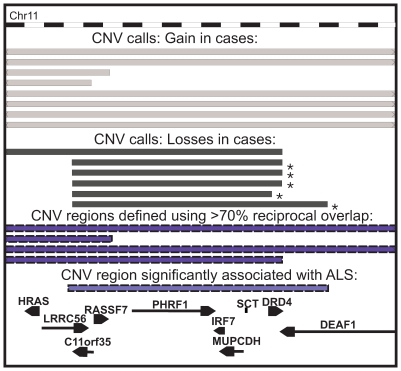
All CNV calls and CNV regions overlapping CNV region chr11: 539119-652407.Raw CNV calls are shown in dark grey. No control losses or gains were detected within the region shown but 8 gains in cases and 6 losses in cases were detected. Blue bars represent CNV regions defined by merging CNV calls that share a greater than 70% reciprocal overlap. The purple bar represents the CNV region found to show significant association in this study: the CNV calls that were merged into this CNV region are indicated with an asterisk. Genes are shown at the bottom. Genomic position is shown along the top.